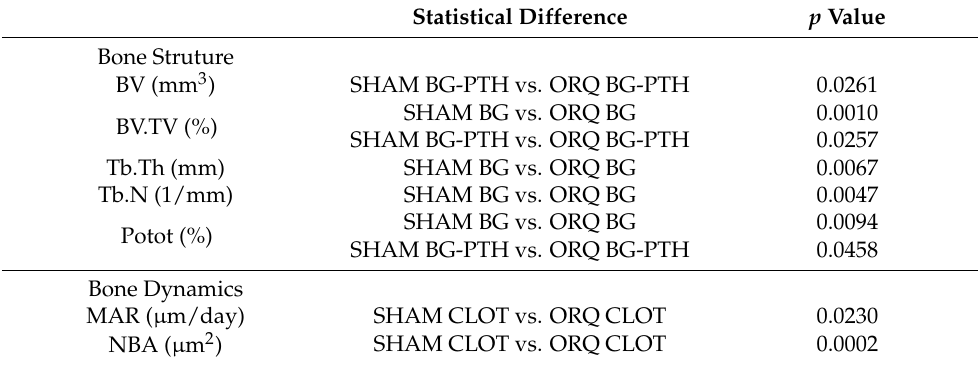
Table 1. Representation intergroup of the statistical difference between SHAM vs. ORQ (CLOT, BG and BG-PTH) for bone structure (BV, BV.TV, Tb.Th, Tb.N, Tb.Sp and Po(tot)) and bone dynamics (MAR and NBA), indicate significance at p <